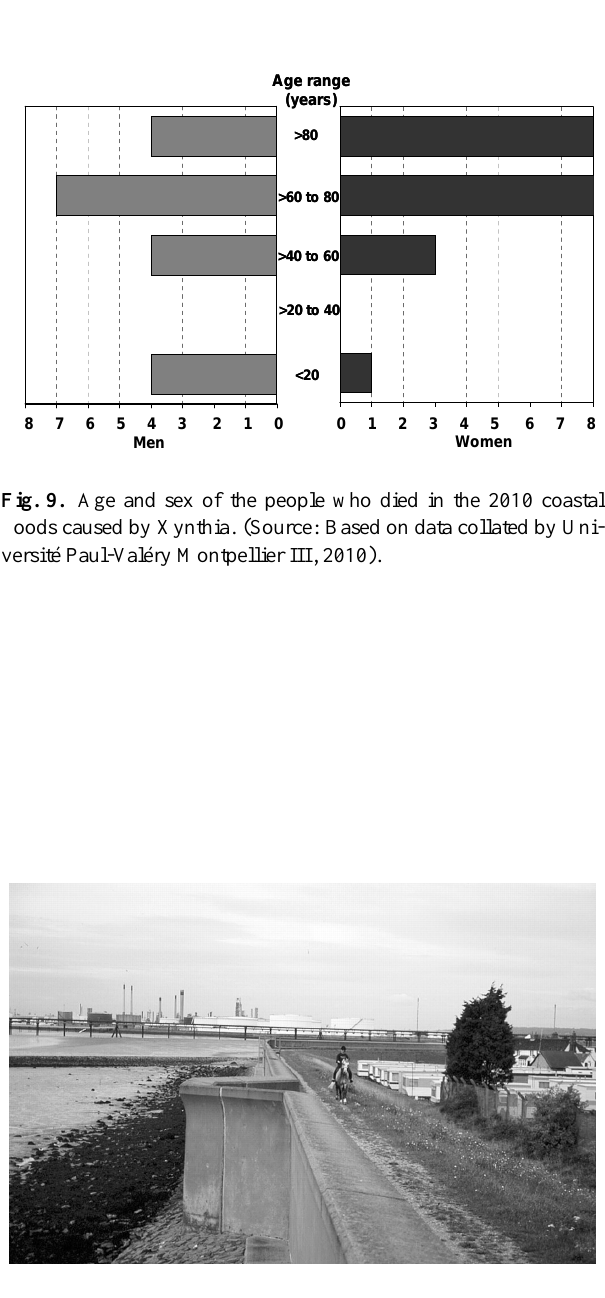
Fig. 10. Improved flood defences built to protect Canvey Island following the 1953 flood. (Source: Baxter, 2005). The following text should have been referenced as follows: